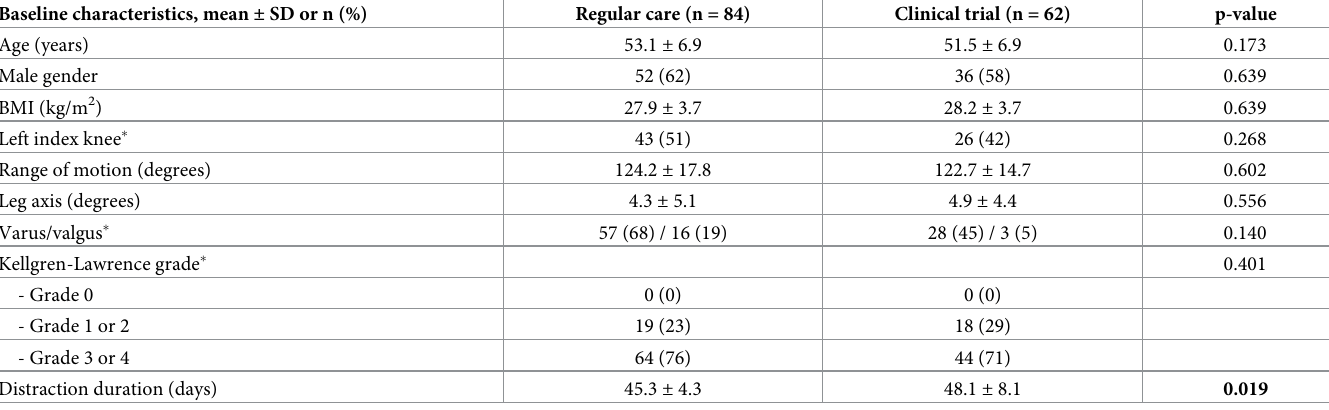
P-values of continuous variables are calculated with independent t-tests and for categorical variables with chi-square tests (indicated with � ). Bold p-values indicate statistical